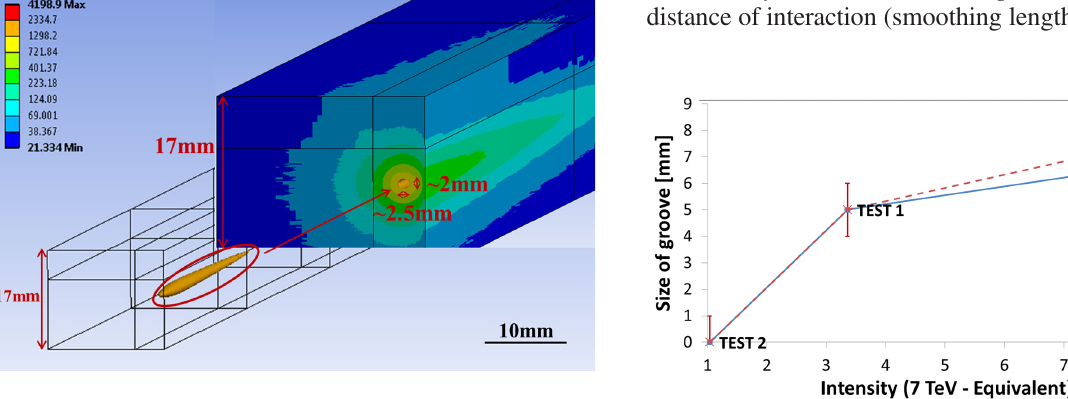
FIG. 22. No groove appears on the surface of the bottom half of the left jaw as shown for Test 2 in Fig. 13, however a small volume of molten material exists within the insert, which means that there may be some structural changes to the material inside the bottom half of the first jaw insert block.